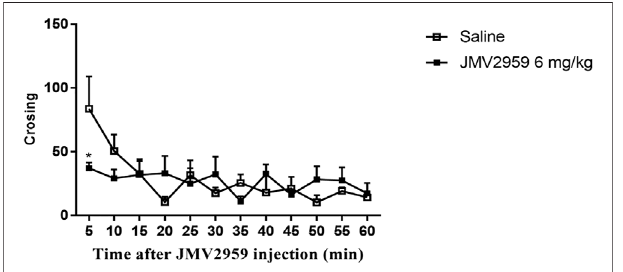
FIGURE 2 | The effect of JMV2959 for rats on locomotor activity. The rats were placed in a photocell cage for 1 h according to the behavioural testing procedure. Then they were injected with vehicle or JMV2959 (0 or 6 mg/kg JMV2959, i.p., respectively) and immediately placed in the chamber. Ambulation behaviour was measured for 60 min. Values are presented as the mean ± SEM ( n (cid:1) 6) * p < 0.05, ** p < 0.01.